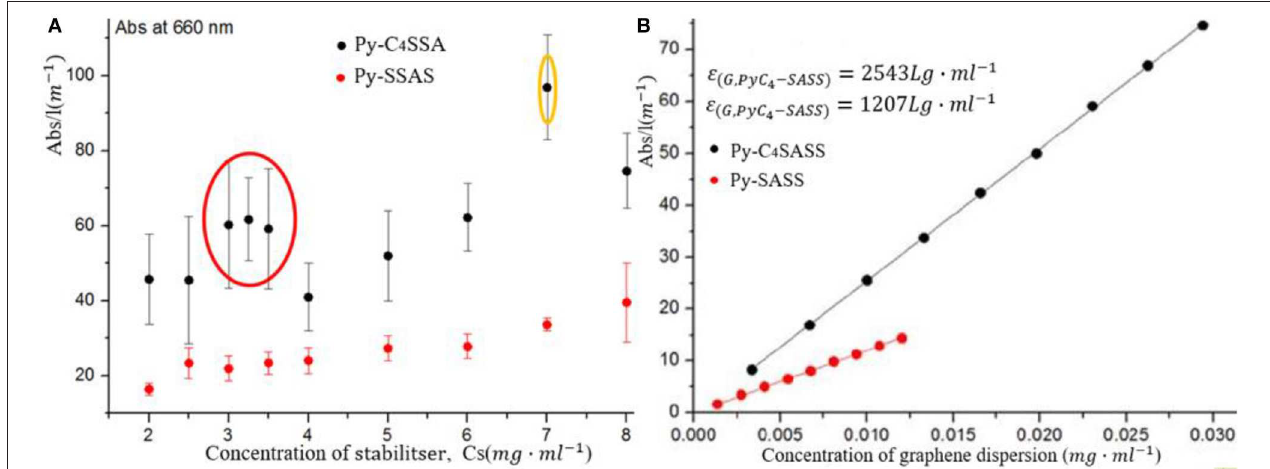
FIGURE 7 | Dispersion of graphene by pyrene derivatives sodium pyrene sulfonate (Py-SASS) and sodium pyrene-butane-1-sulfonate (Py-C 4 -SASS). (A) Comparison of the stripping ability of the two dispersants to graphene. (B) UV-Vis test analysis results of the two dispersant systems.